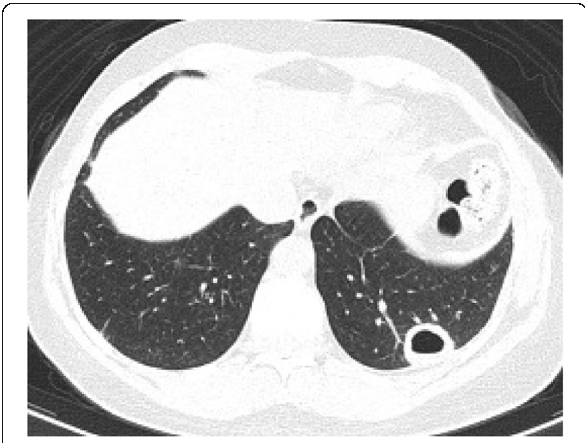
Fig. 1 (abstract P488). Thorax tomography showing cavitated